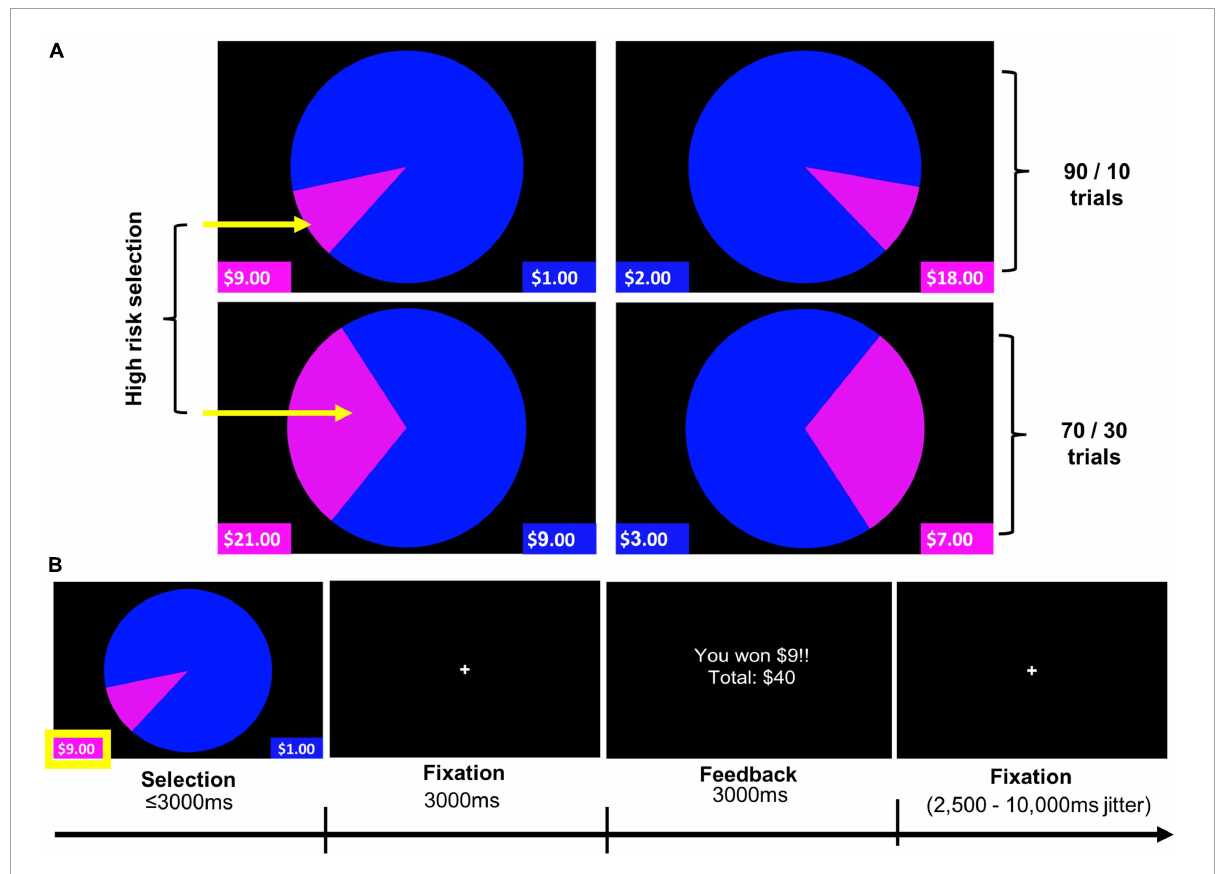
FIGURE1 Wheel of Fortune (WOF) task. (A) Task stimuli illustrating two trial types (90/10 and 70/30), and highlighting high-reward/risk selections for each of these trial types. (B) Example trial timing. Pressing the left button, corresponding to the smaller, magenta portion of the wheel, represents selection of the high-reward/risk option (10% chance of receiving $9), over the low-reward/risk option depicted in blue (90% chance of receiving $1). Analyses reported examined Selection and Feedback phases of the task.